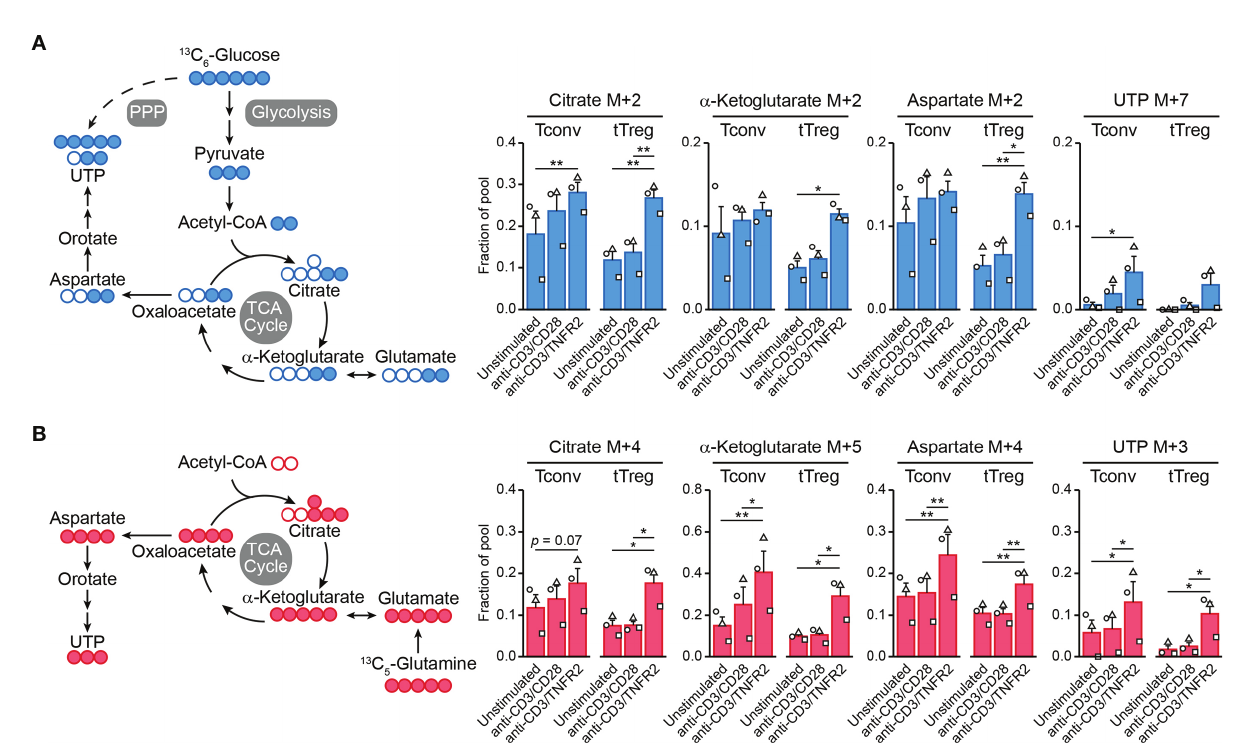
FIGURE 2 | TNFR2 costimulation regulates Tconv and tTreg metabolism. Tconvs and tTregs were sorted as in Figure 1 and pre-expanded for 1 week. Subsequently, cells were restimulated as indicated for 24 h in the presence of IL-2 and either [ 13 C 6 ]-glucose (A) or [ 13 C 5 ]-glutamine (B) and analyzed by liquid chromatography – mass spectrometry (LC – MS) to trace 13 C-labeled metabolites. (A, B) Left panels: schematic diagrams of the fate of 13 C in metabolic pathways following [ 13 C 6 ]-glucose uptake (blue) or [ 13